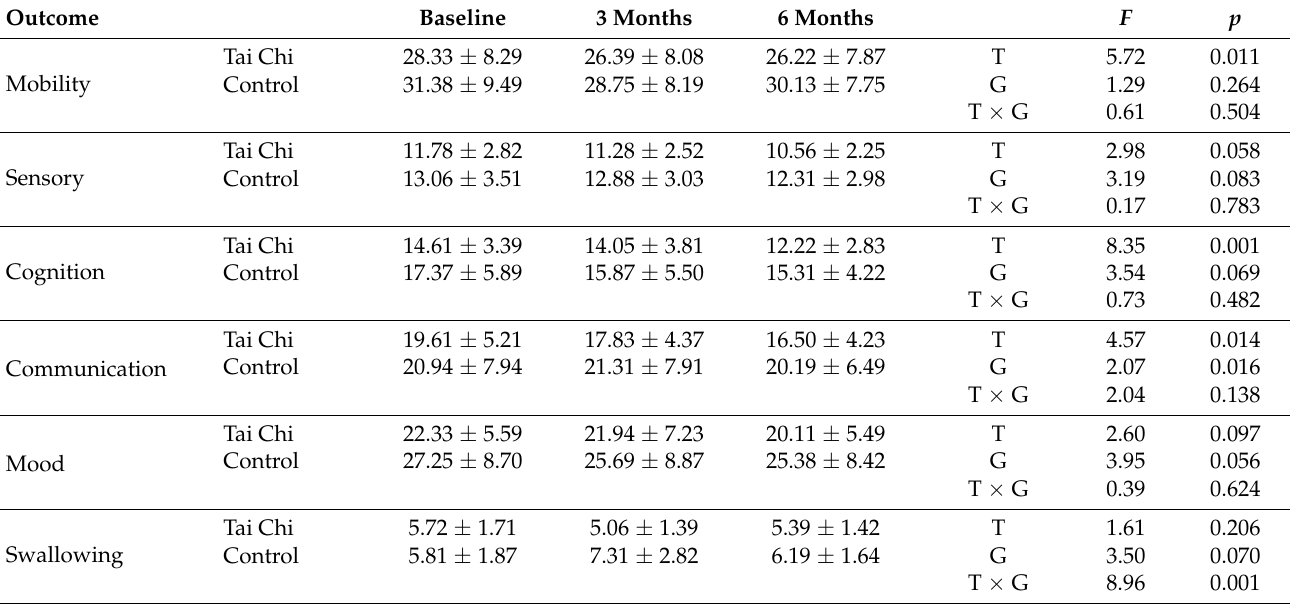
Table 3. Effects of the Tai Chi-based stroke rehabilitation program on symptom clusters ( N = 34).